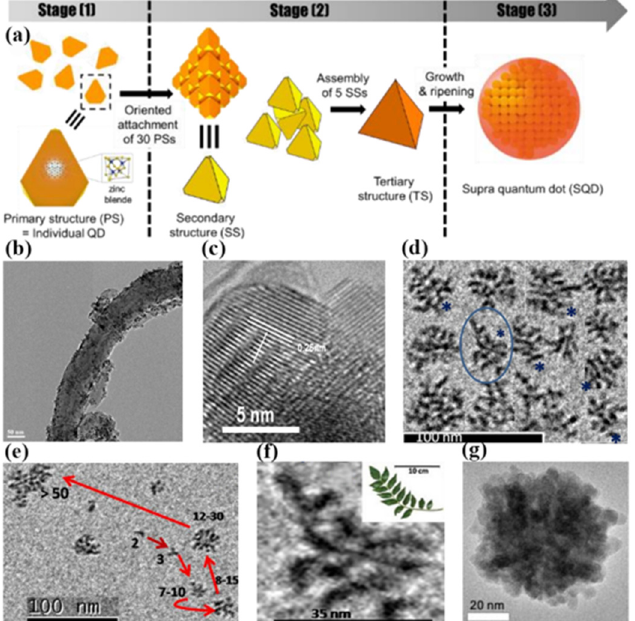
Figure 7. ( a ) Schematic illustration of different growth stages of SQDs with the assembly mechanisms. ( b ) TEM image of a single multi-walled carbon nanotubes coupling with ZnO QDs. ( c ) HRTEM image of ZnO QDs beaded on the sidewalls of multi-walled carbon nanotubes [48]. Copyright 2009, Carbon . ( d ) TEM image of assemblies of ZnO QDs into various dendritic nanostructures (* represents 1D nanostructures). ( e ) TEM image illustrating process of the evolution of large dendritic nanostructure from drop shape QDs (Arrows illustrate the process of evolution of large dendritic nanostructure from drop shape QDs.) and ( f ) enlarged image of a single ZnO dendron [49]. Copyright 2012, Applied Surface Science. ( g ) TEM image of CdSe SQDs [50]. Copyright 2016, Chemistry of Materials